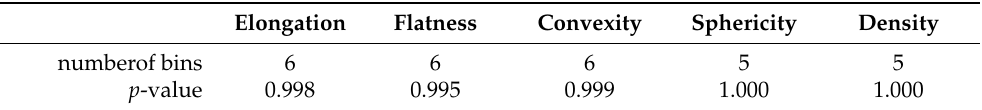
Figure 1. Some examples of particle shapes considered via superellipsoids. Depicted (from left to right and top to bottom) are the particles with ID 5, 17, 28, 143, 166 and 200, according to Appendix A. Table 1. Results of a chi-squared test for equal distribution of frequencies of different shape